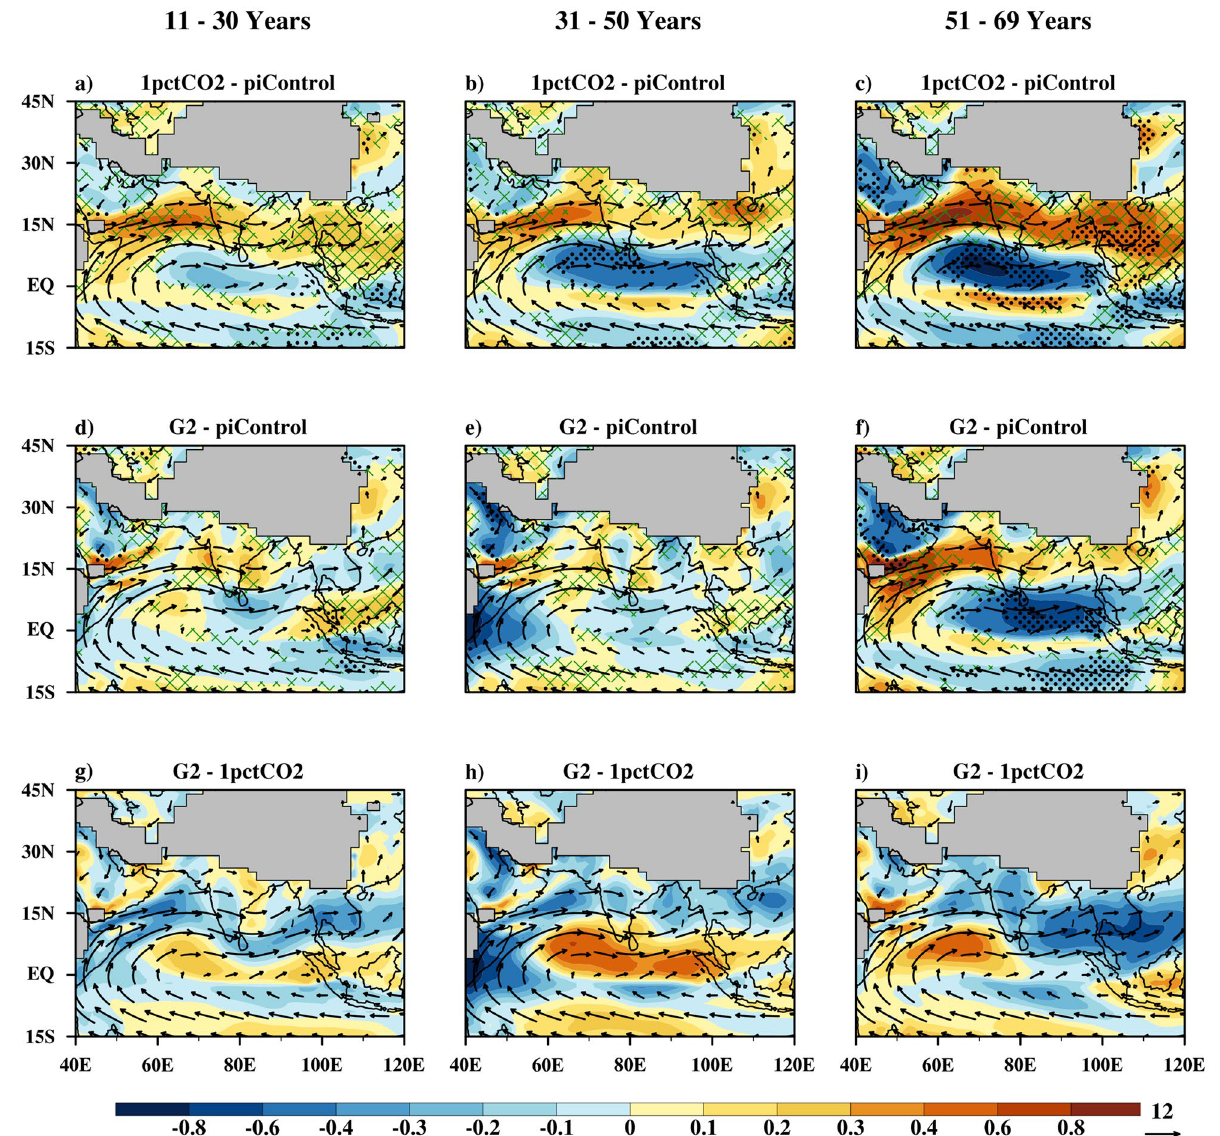
Figure 3. As in Fig. 2 but for wind speed (m/s) at 850 hPa. Vectors show piControl winds at same